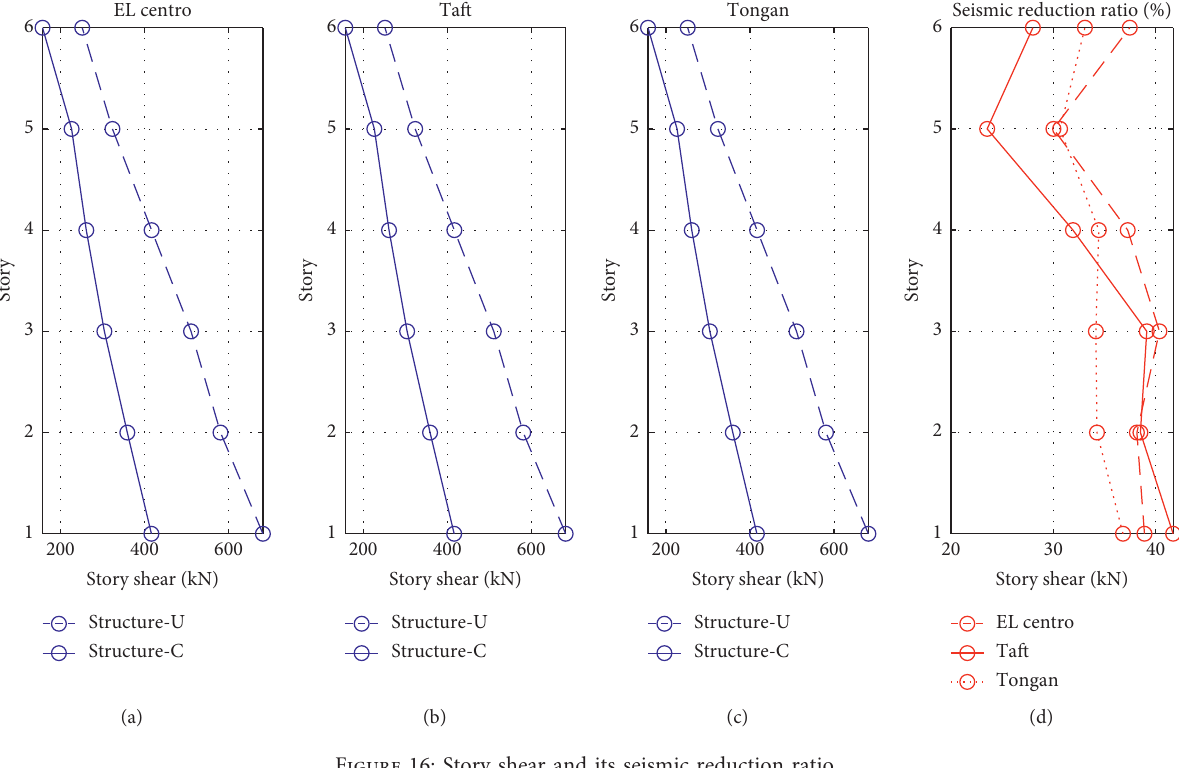
Figure 16: Story shear and its seismic reduction ratio.